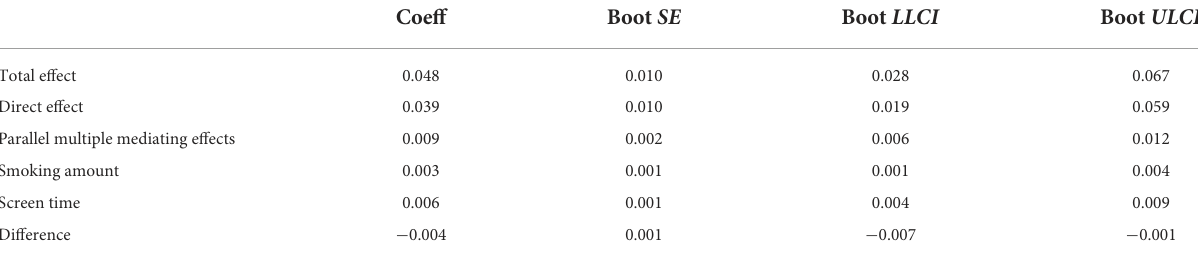
TABLE 4 Bootstrap tests of mediating effect between smoking amount, screen time, education years, and BMI in older